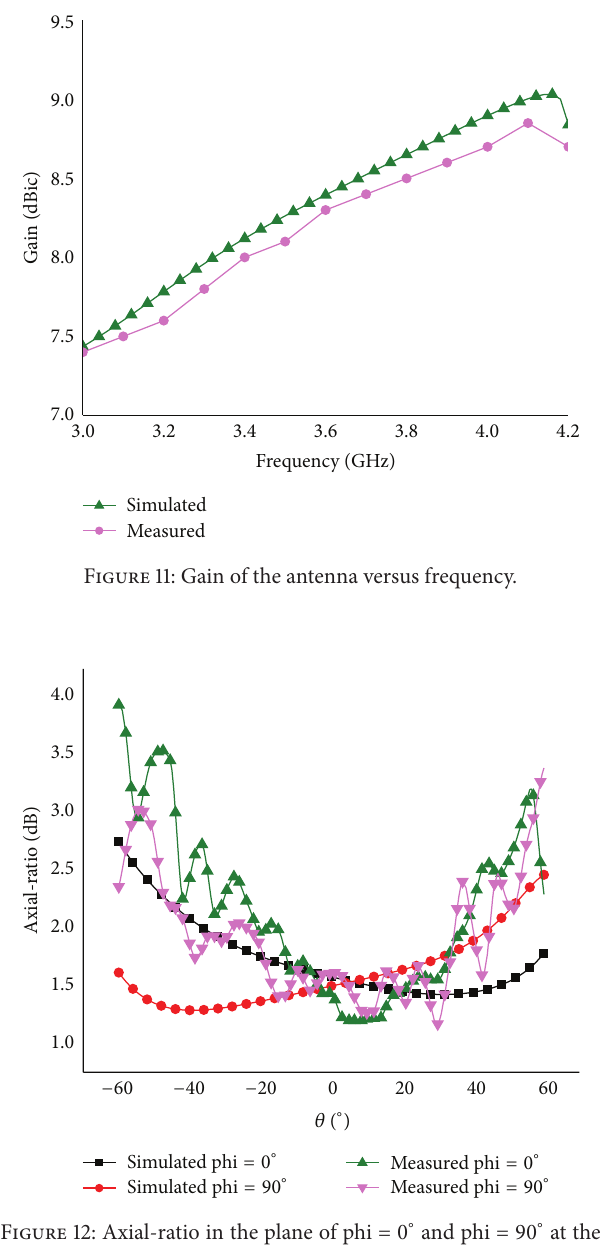
Figure 12: Axial-ratio in the plane of phi = 0 ∘ and phi = 90 ∘ at the centre frequency of 3.7 GHz.